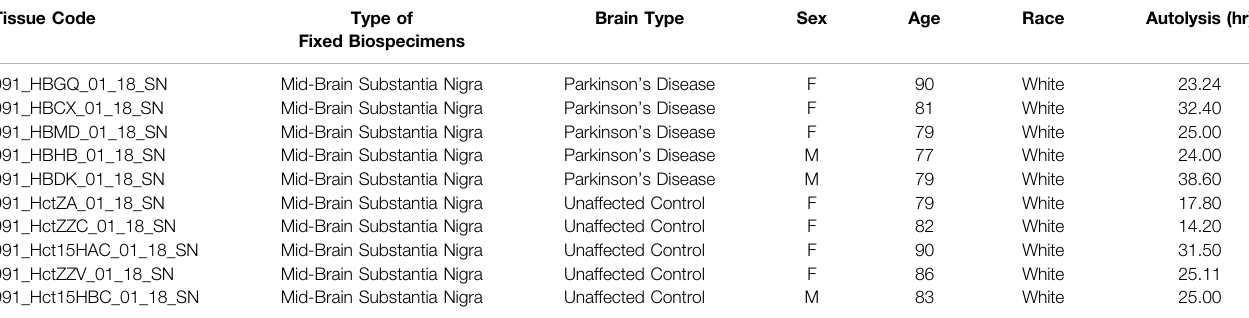
TABLE 1 | Parkinson ’ s disease patients and control subjects